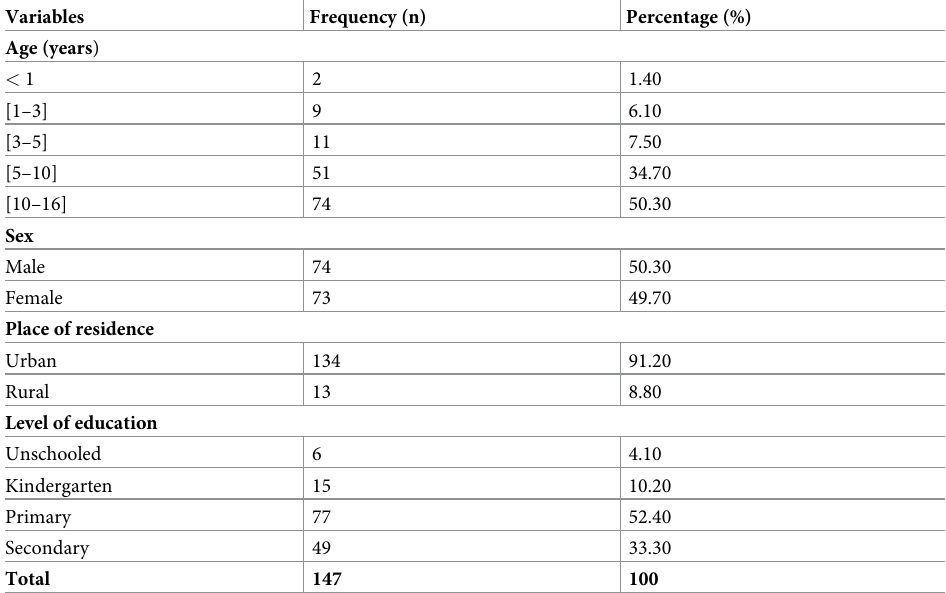
Table 1. Sociodemographic characteristics of children infected with HIV at Laquintinie hospital in Douala.